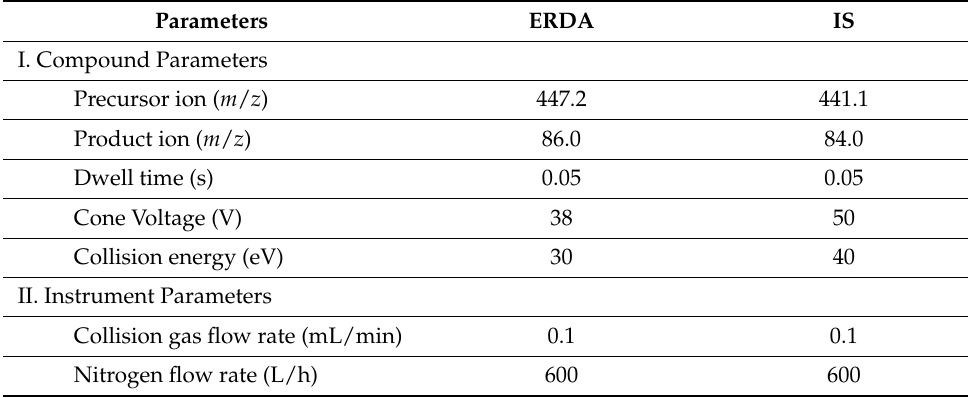
Figure 2. Product ion spectra of the ERDA ( A ) and IS ( B ) in positive ionization mode. Table 1. Mass optimization parameters for ERDA and